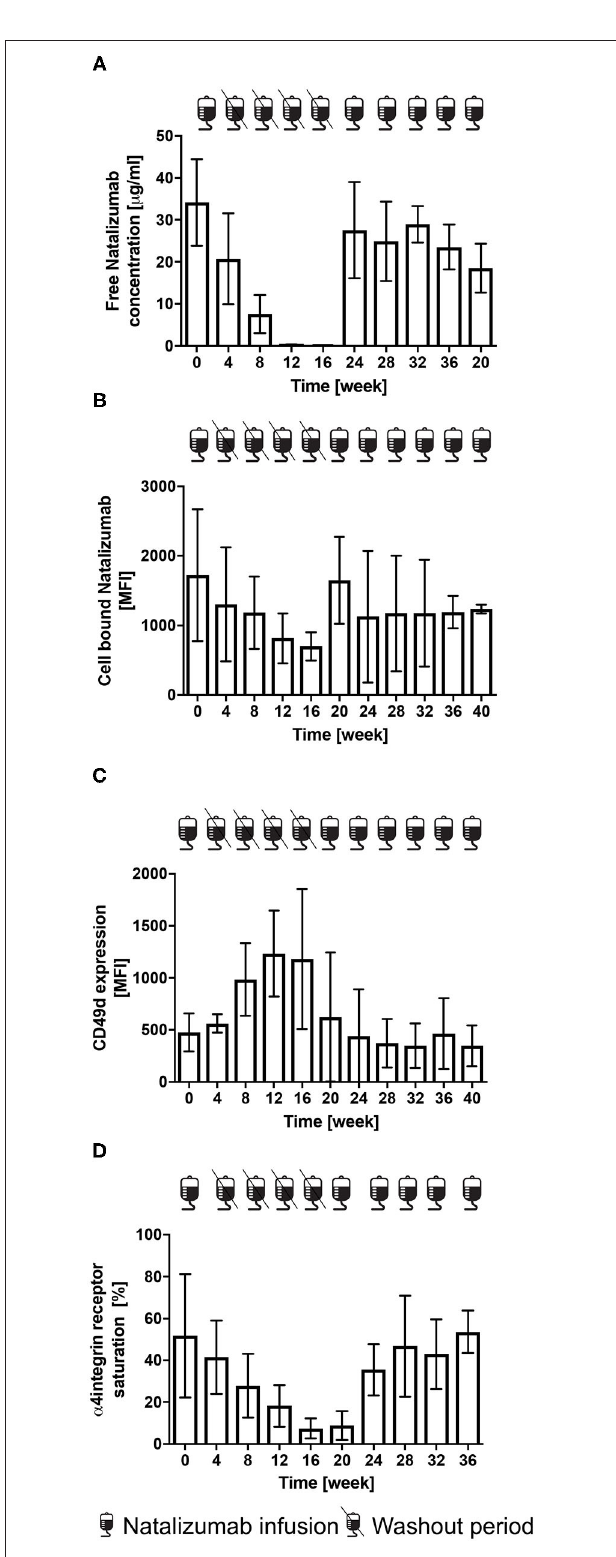
FIGURE 6 | Free NAT concentration, cell bound NAT, CD49 d expression and α 4-integrin saturation after the cessation and restart of NAT therapy in RRMS patients ( n = 5). Mean levels ± SD of free NAT concentration in plasma (A) ,